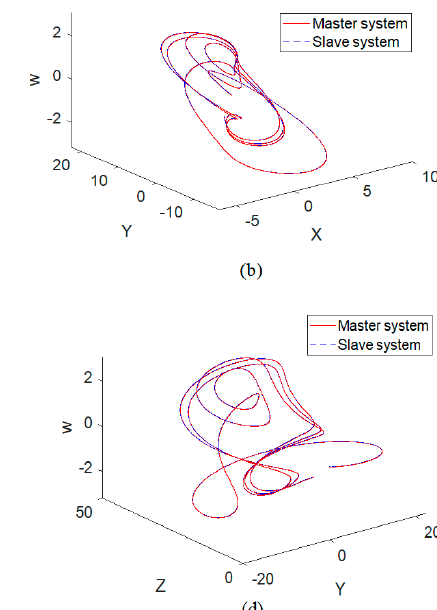
Figure 8. System outputs between the proposed SRIT2PC and other synchronization methods for Case 1: ( a ) 1 2 , x x , ( b ) 1 2 , y y , ( c ) 1 2 , z z , and ( d ) 1 2 , w w . Figure 9. Control signals between the proposed SRIT2PC and other synchronization methods for Case 1: ( a )